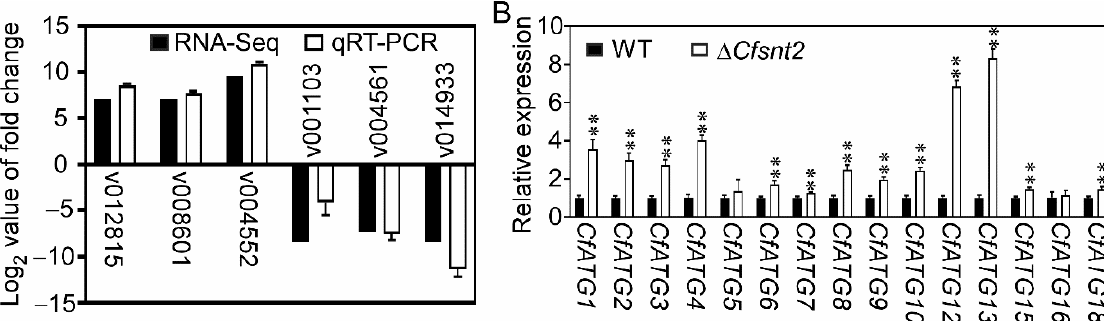
Figure 5. The gene expression levels in WT and Δ Cfsnt2 mutant. ( A ) QRT-PCR analysis of the expression levels for selected 3 up-regulated genes and 3 down-regulated genes in the transcriptomic data of WT and Δ Cfsnt2 mutant. ( B ) QRT-PCR analysis of the expression levels of CfATG genes in WT and Δ Cfsnt2 mutant. Error bars indicate standard deviation (SD) of three biological replicates (** p < 0.01).